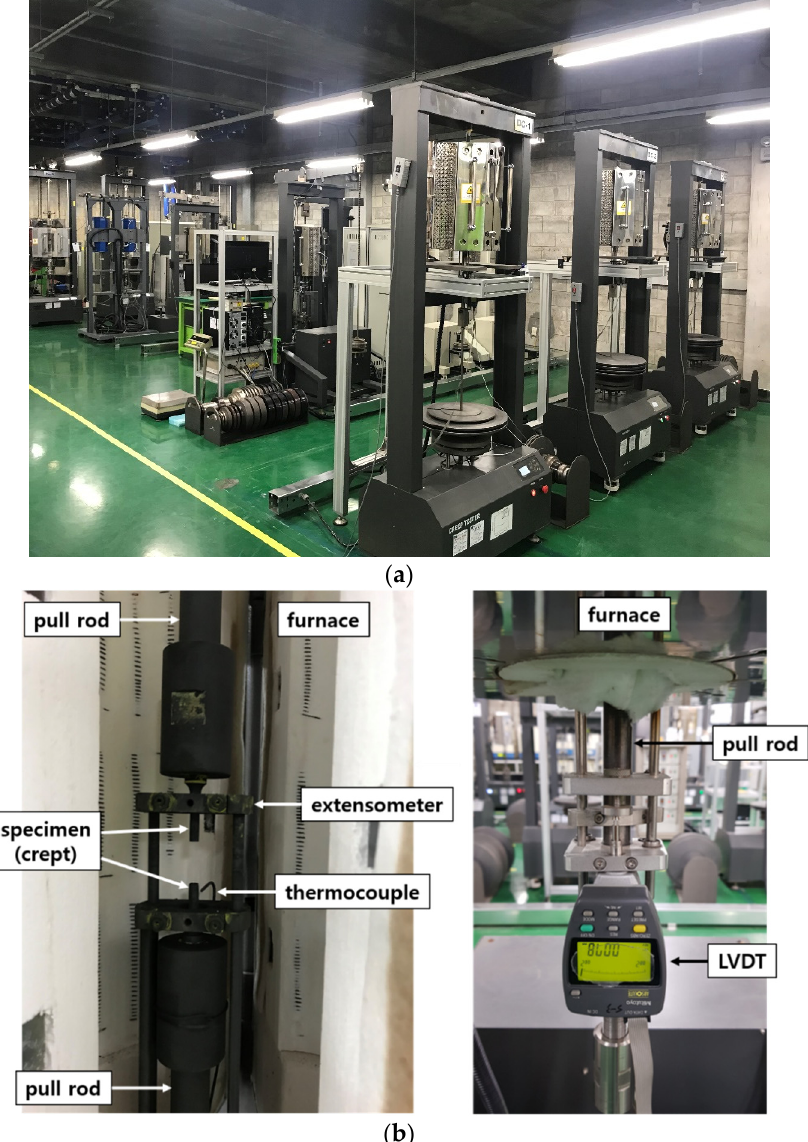
Figure 2. ( a ) Test apparatuses for the stress-rupture test and ( b ) elongation-measuring system.